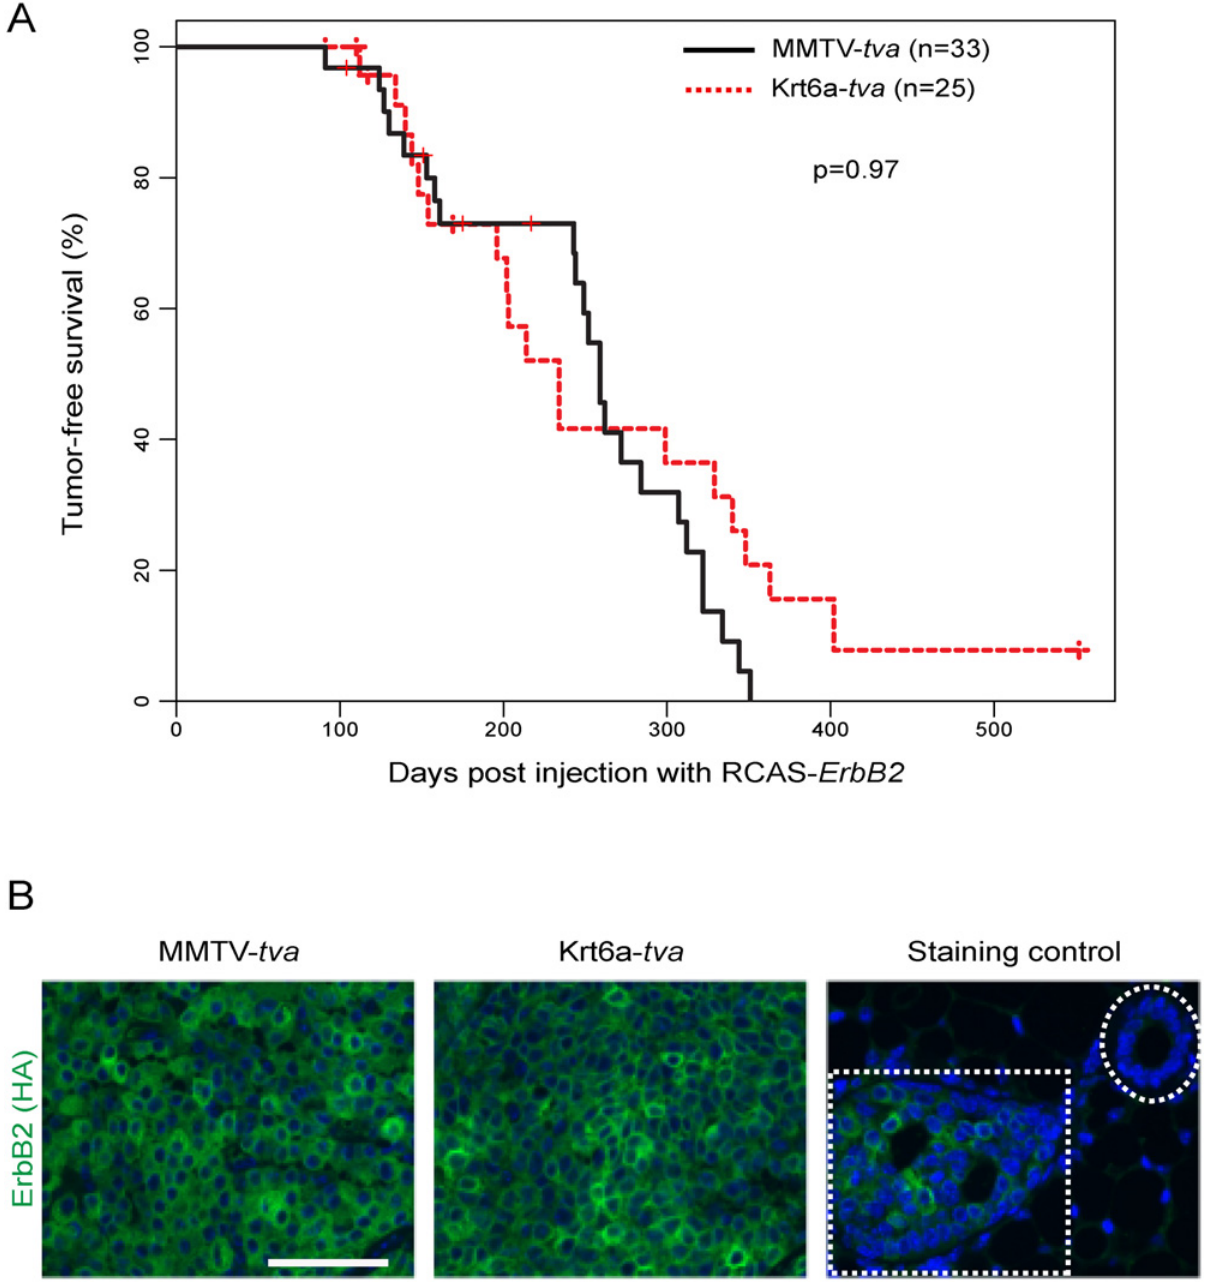
Fig 2. ErbB2 initiated tumors with comparable latency in MMTV- tva and K6a- tva mice. (A) Kaplan-Meier tumor-free survival curves of RCAS-ca ErbB2 -infected mice of the indicated genotypes. (B) Immunofluorescent staining for HA-tagged ErbB2 in tumors from MMTV- tva and K6a- tva mice (scale bar: 50 um). Antibody specificity was determined by staining early lesions expressing HA-tagged ErbB2 (third panel, bottom left; positive control) and normal ducts (third panel, top right; negative control).